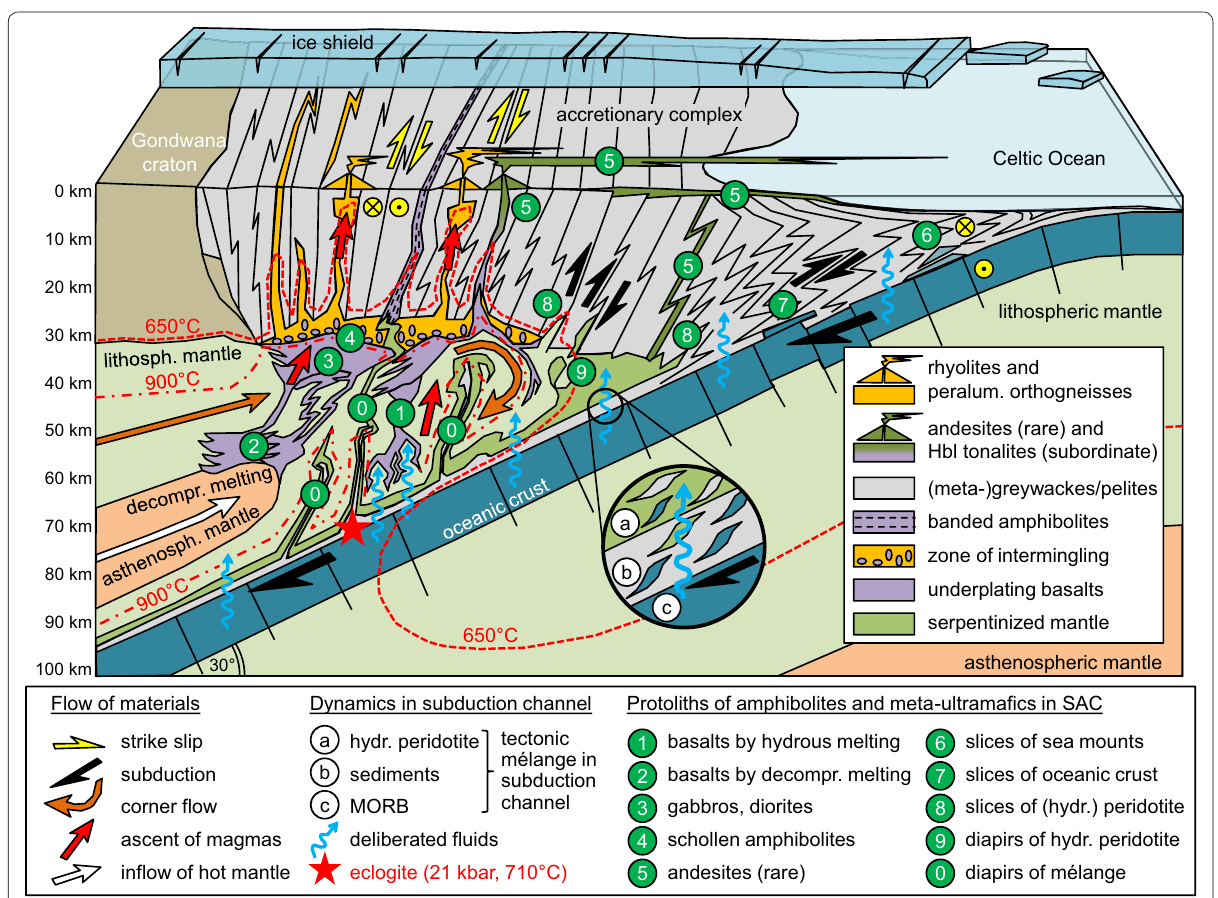
Fig. 13 Tectonic setting of the early Paleozoic subduction–accretion complex (SAC) exposed in the pre-Mesozoic basement units of the Alps (Zurbriggen 2017). The flow paths of materials are symbolized with different arrows (see left part of legend in the lower box). The dynamics in the subduction channel (Cloos and Shreve 1988; see middle part of legend in the lower box) produce tectonic mélanges, which can be dragged to large depths and rise as cold diapirs. Possible protoliths for amphibolites and associated meta-ultramafics are indicated with numbers (see right part of legend in the lower box). P–T data of eclogites are taken form Franz and Romer (2007), who dated the eclogites of the Strona-Ceneri Zone to be